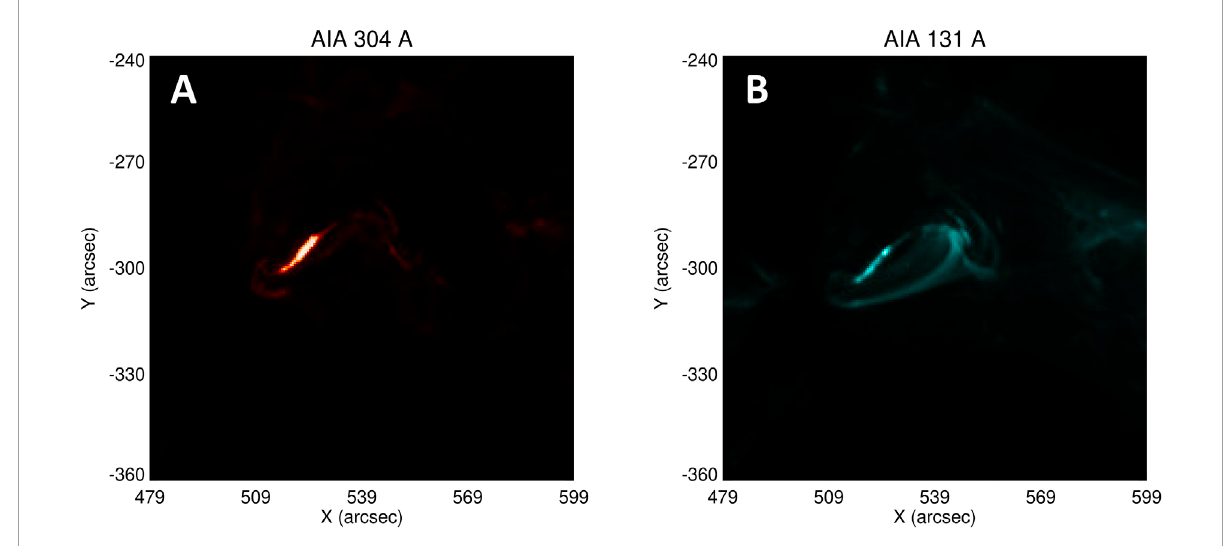
FIGURE 1 Images taken in the 304 Å (A) and 131 Å (B) SDO/AIA channels on 2014 October 26 around 12:48 UT. The images have the standard 0 ′′ .6 × 0 ′′ .6 pixel size; each image is 200 × 200 pixels, or 120 ′′ × 120 ′′ .